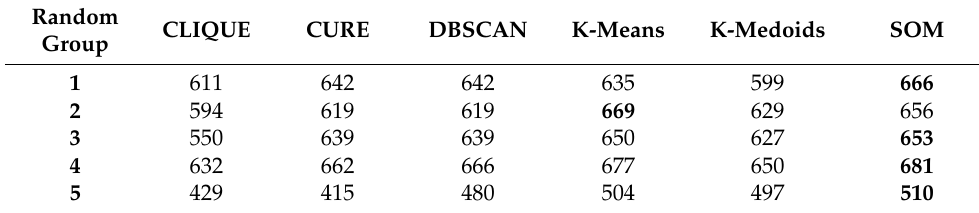
Table 2. Evaluation results based on the rating